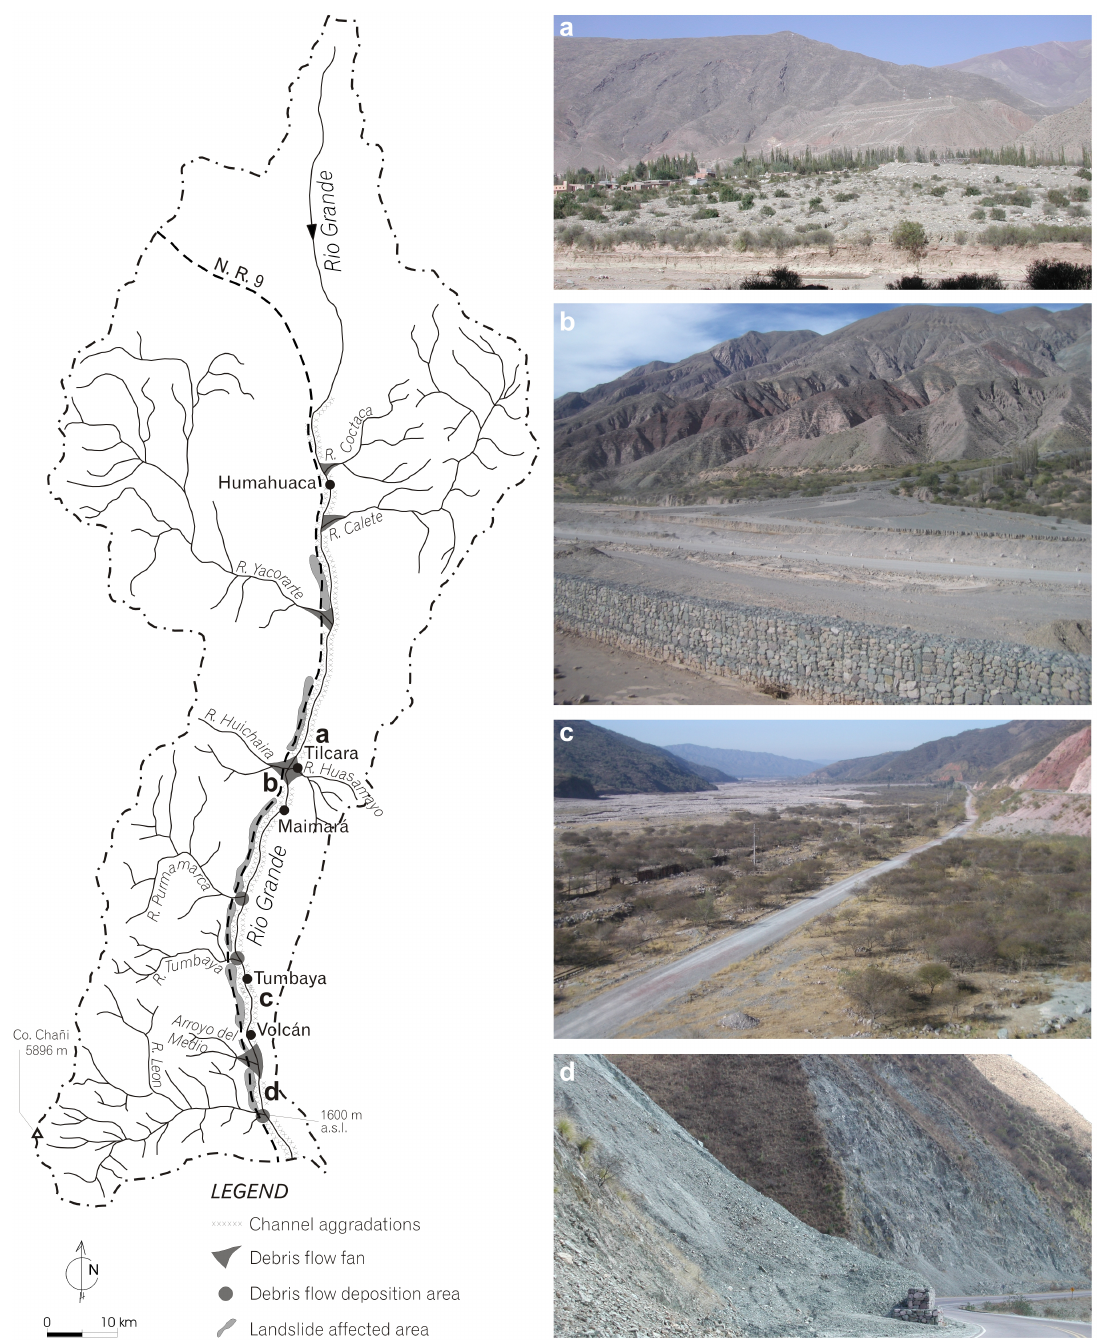
Fig. 3. Quebrada de Humahuaca watershed. The main tributaries and villages along the valley are indicated. (a) A detail of Rio Huasamayo alluvial fan, where Tilcara village is located. The village is permanently threatened by the debris flow phenomena. (b) Quebrada de Trancas, close to Maimar`a village. At the confluence with Rio Grande, the alluvial fan generation, due to the recurrent debris flow phenomena, causes the progressive deviation of the Rio Grande riverbed, which, in turn, tends to erode the right river bank. It was necessary to set up a series of gabions in order to protect the N. R. n. 9 Panamericana. (c) Rio Grande riverbed, between Timbaya and Volcan. Due to the alluvial aggradation, the Ferrocaril General Belgrano and the old path of Ruta Nacional were abandoned in 1992. The new road has been rebuilt upslope. (d) n. 9 new route is under a continuous maintenance, due to the frequent debris slides triggering by undercutting